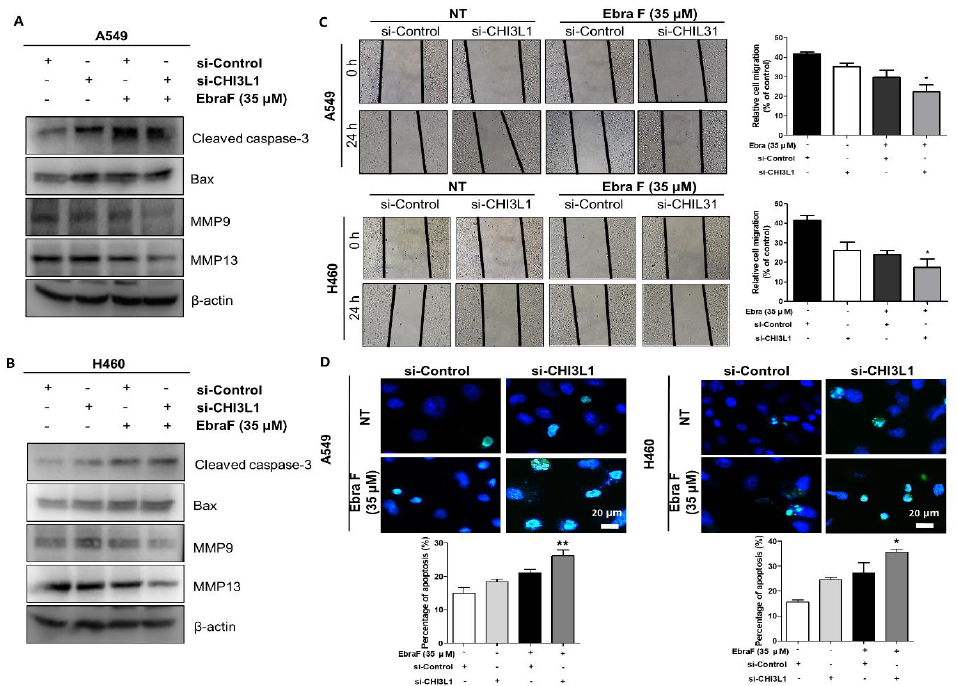
Figure 6. Combination effects of ebractenoid F and CHI3L1 siRNA on cell growth, migration, and apoptosis, as well as related protein expression. The lung cancer cells were transfected with CHI3L1 siRNA for 24 h and then treated with ebractenoid F for 24 h. The expression of migration and apoptosis-related proteins were detected by Western blot analysis in A549 and H460 cells ( A , B ). Wound healing assay was performed in the same way as previously mentioned ( C ). TUNEL assay was performed in the same way as previously mentioned ( D ). The values represent the means ± S.D. of three experiments. *, p ≤ 0.05; **, p < 0.01; n.s. (not statistically significant) indicates statistically significant differences from the control